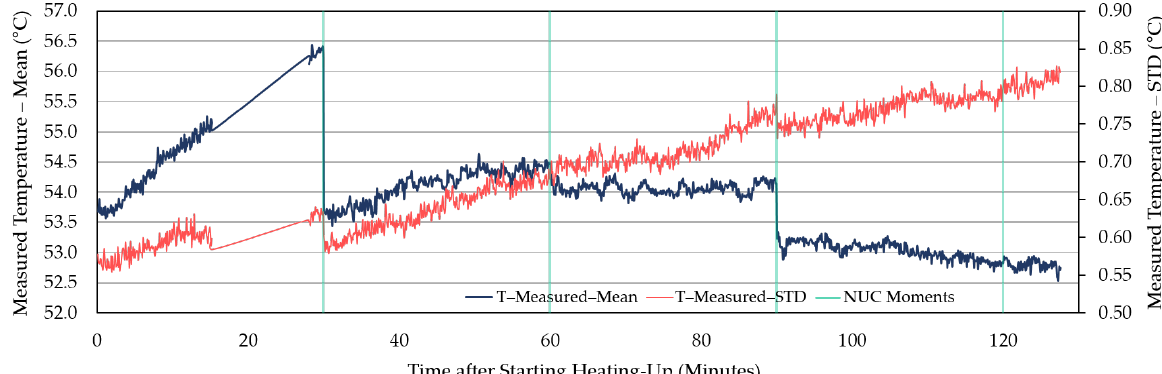
Figure 4. The measured average temperature of the blackbody calibrator (55 °C) area, as recorded by WIRIS 2nd GEN over 2 h after switching on the camera. The STD of the measured temperature is also included. In this session, the NUCs were enabled every 2 min .